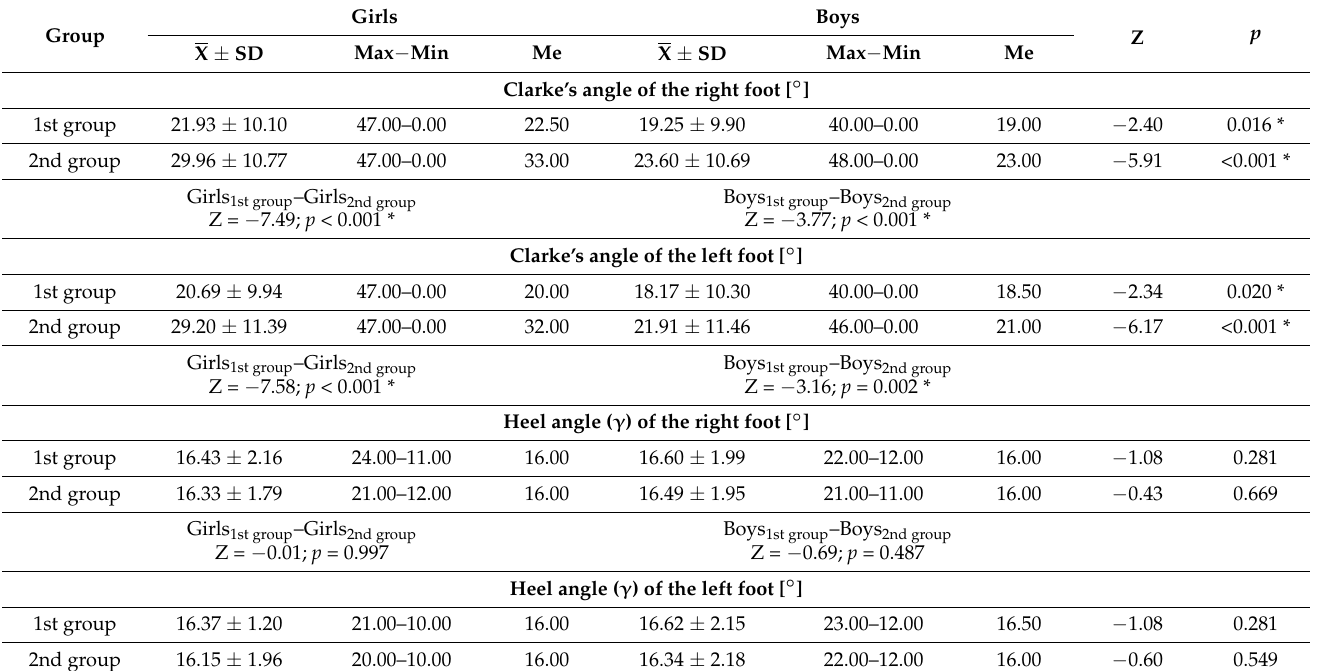
Table 4. The comparison of characteristics determining the longitudinal and transverse foot arches as well as the position of the hallux and Vth toe in 3-year-old girls and boys, taking into account half-yearly age